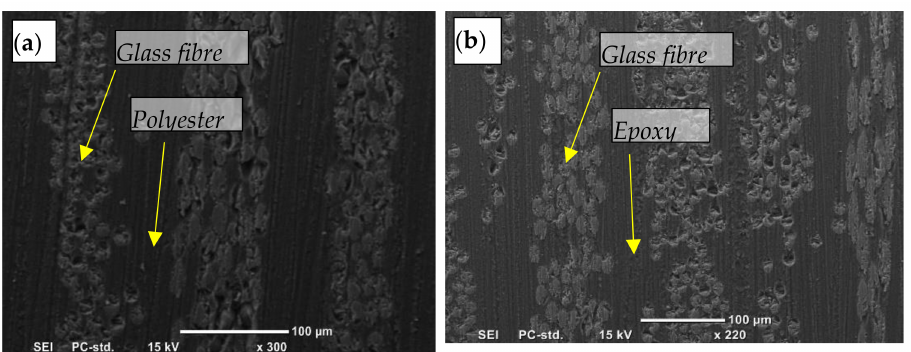
Figure 1. Micrographs of the original surfaces of ( a ) GFRP and ( b ) GFRE.